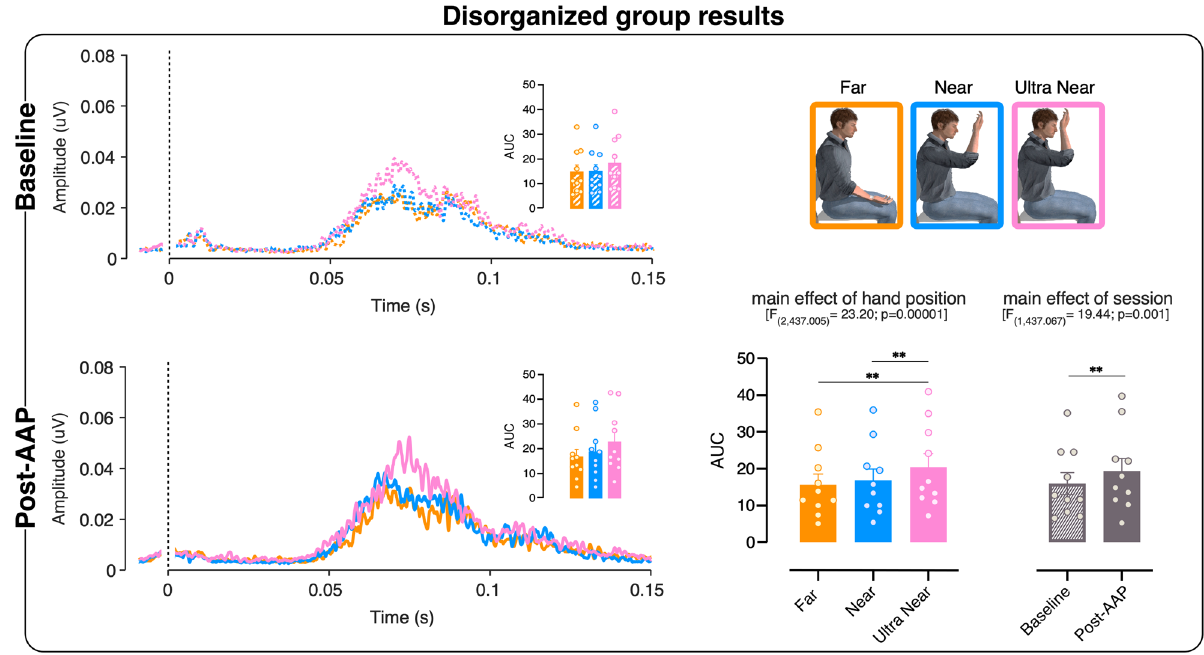
Figure 3. Disorganized group results. Left panels, rectified hand blink reflex (HBR) waveforms (group ‐ average) in the three different hand positions: Far (orange), Near (light blue), and Ultra Near (pink). The dotted line at 0 s represents the stimulus delivery. The histograms represent the HBR magnitude (AUC) in the three hand positions. Bottom right panel, main effect of hand position and main effect of session. The error bars show the standard error of the mean (SEM) and the asterisk shows the significant difference (*p < 0.05). The dots represent individual participants. The images were created with the following software: Matlab R2020b (https:// it. mathw orks. com/ produ cts/ matlab. html) and GraphPad Prism 8 (https:// www. graph pad. com/ scien tific- softw are/ prism/) were used to plot the data. Canvas Draw (https:// www. canva sgfx. com/ produ cts/ canvas- x- draw) was then used to combine all components of the figure into a single panel.